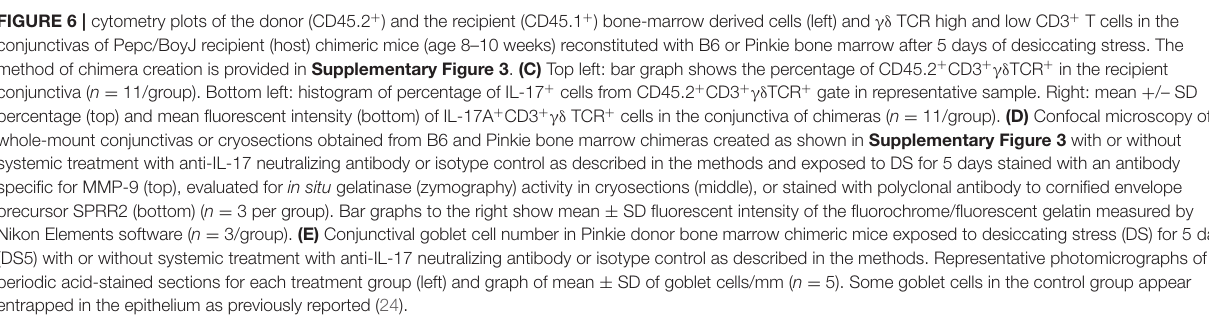
FIGURE 6 | cytometry plots of the donor (CD45.2 + ) and the recipient (CD45.1 + ) bone-marrow derived cells (left) and γδ TCR high and low CD3 + T cells in the conjunctivas of Pepc/BoyJ recipient (host) chimeric mice (age 8–10 weeks) reconstituted with B6 or Pinkie bone marrow after 5 days of desiccating stress. The method of chimera creation is provided in Supplementary Figure 3 . (C) Top left: bar graph shows the percentage of CD45.2 + CD3 + γδ TCR + in the recipient conjunctiva ( n = 11/group). Bottom left: histogram of percentage of IL-17 + cells from CD45.2 + CD3 + γδ TCR + gate in representative sample. Right: mean + /– SD percentage (top) and mean fluorescent intensity (bottom) of IL-17A + CD3 + γδ TCR + cells in the conjunctiva of chimeras ( n = 11/group). (D) Confocal microscopy of whole-mount conjunctivas or cryosections obtained from B6 and Pinkie bone marrow chimeras created as shown in Supplementary Figure 3 with or without systemic treatment with anti-IL-17 neutralizing antibody or isotype control as described in the methods and exposed to DS for 5 days stained with an antibody specific for MMP-9 (top), evaluated for in situ gelatinase (zymography) activity in cryosections (middle), or stained with polyclonal antibody to cornified envelope precursor SPRR2 (bottom) ( n = 3 per group). Bar graphs to the right show mean ± SD fluorescent intensity of the fluorochrome/fluorescent gelatin measured by Nikon Elements software ( n = 3/group). (E) Conjunctival goblet cell number in Pinkie donor bone marrow chimeric mice exposed to desiccating stress (DS) for 5 days (DS5) with or without systemic treatment with anti-IL-17 neutralizing antibody or isotype control as described in the methods. Representative photomicrographs of periodic acid-stained sections for each treatment group (left) and graph of mean ± SD of goblet cells/mm ( n = 5). Some goblet cells in the control group appear entrapped in the epithelium as previously reported